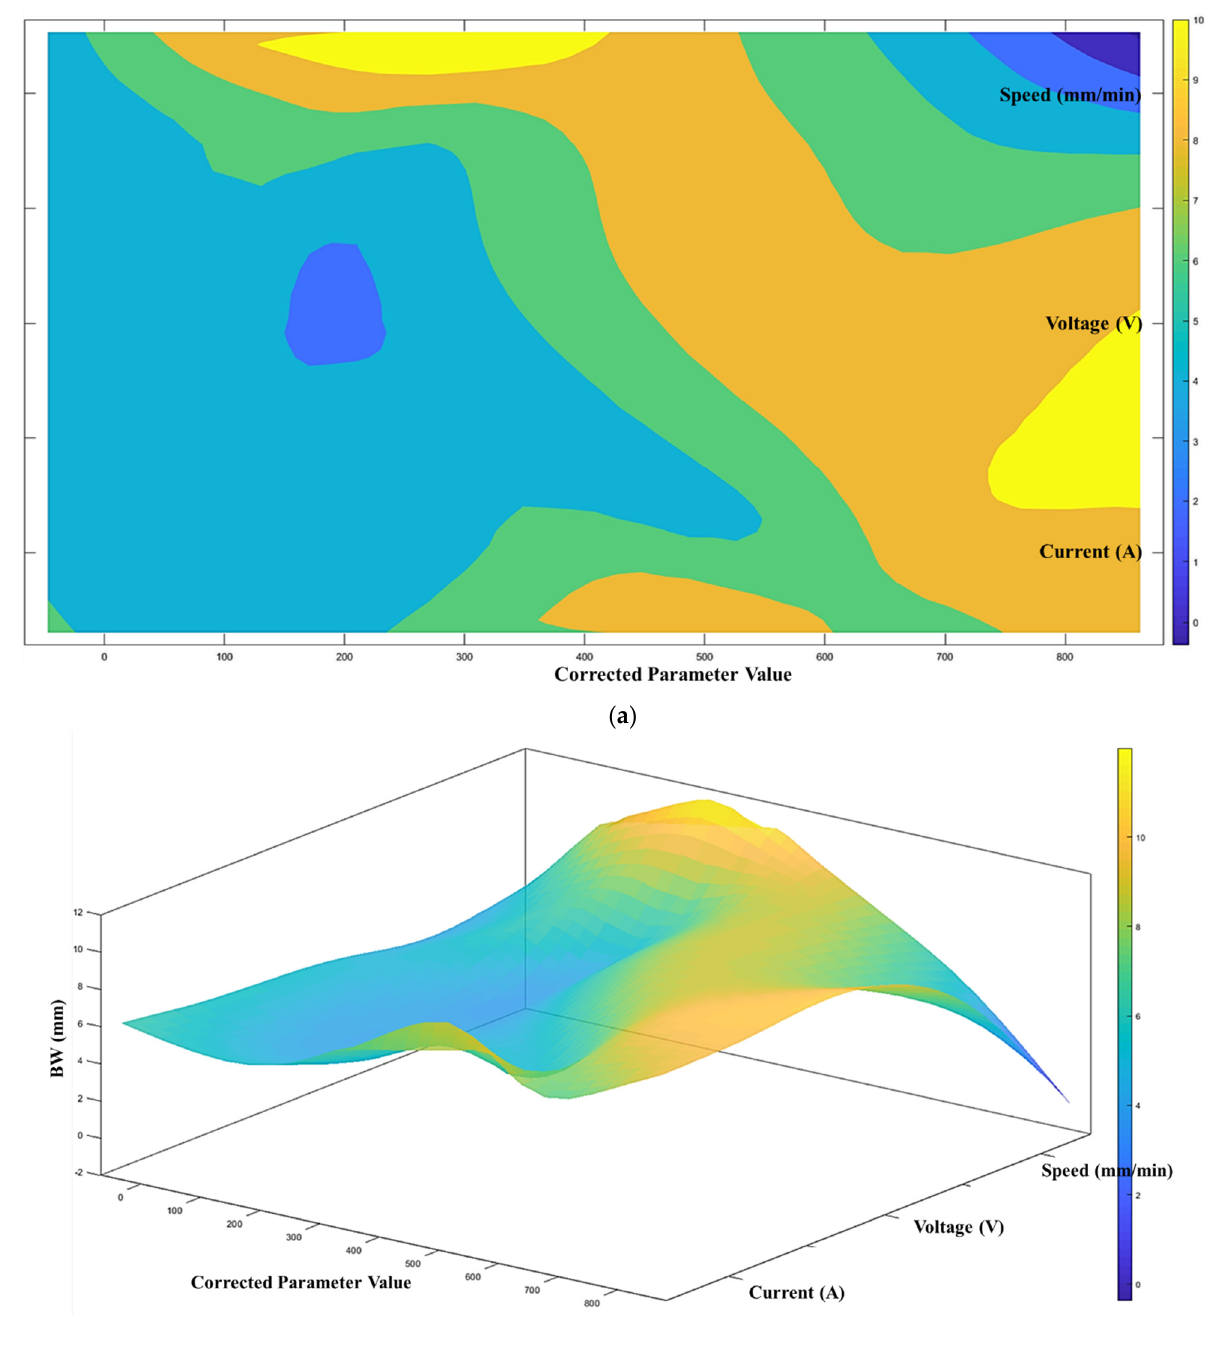
Figure 7. ( a ) Process-quality model (bead width) using current, voltage, and speed (contour), ( b ) process-quality model (bead width) using current, voltage, and speed (3D).